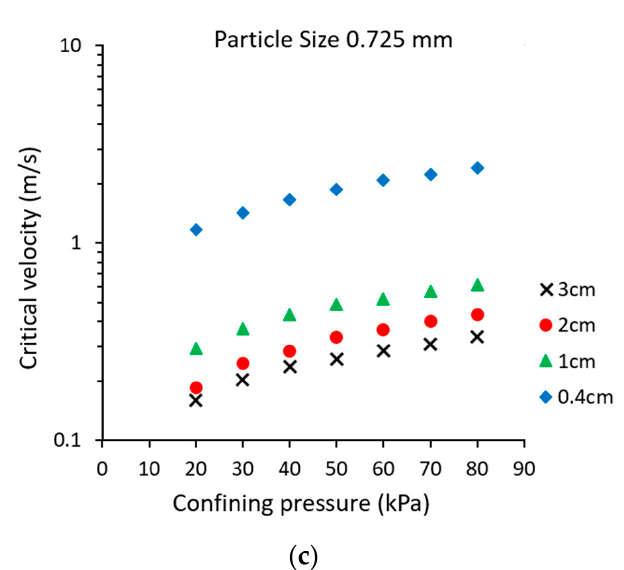
Figure 6. Critical velocity with various confining pressure: ( a ) particle size of 0.091 mm; ( b ) particle size of 0.338 mm; ( c ) particle size of 0.725 mm.